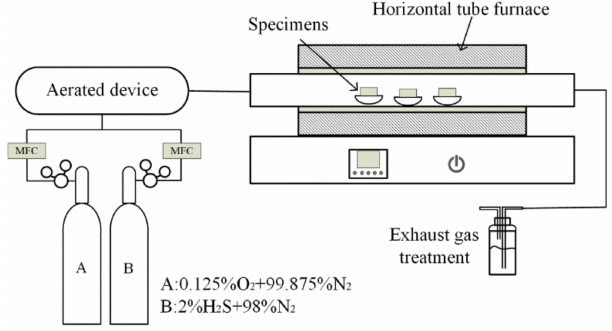
Figure 2. Experimental setup for the corrosion